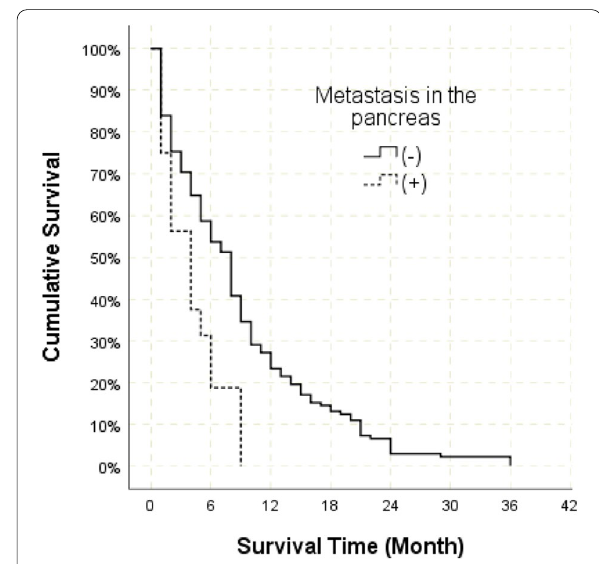
Fig. 1 N stage and survival Fig. 2 Pancreas metastasis and